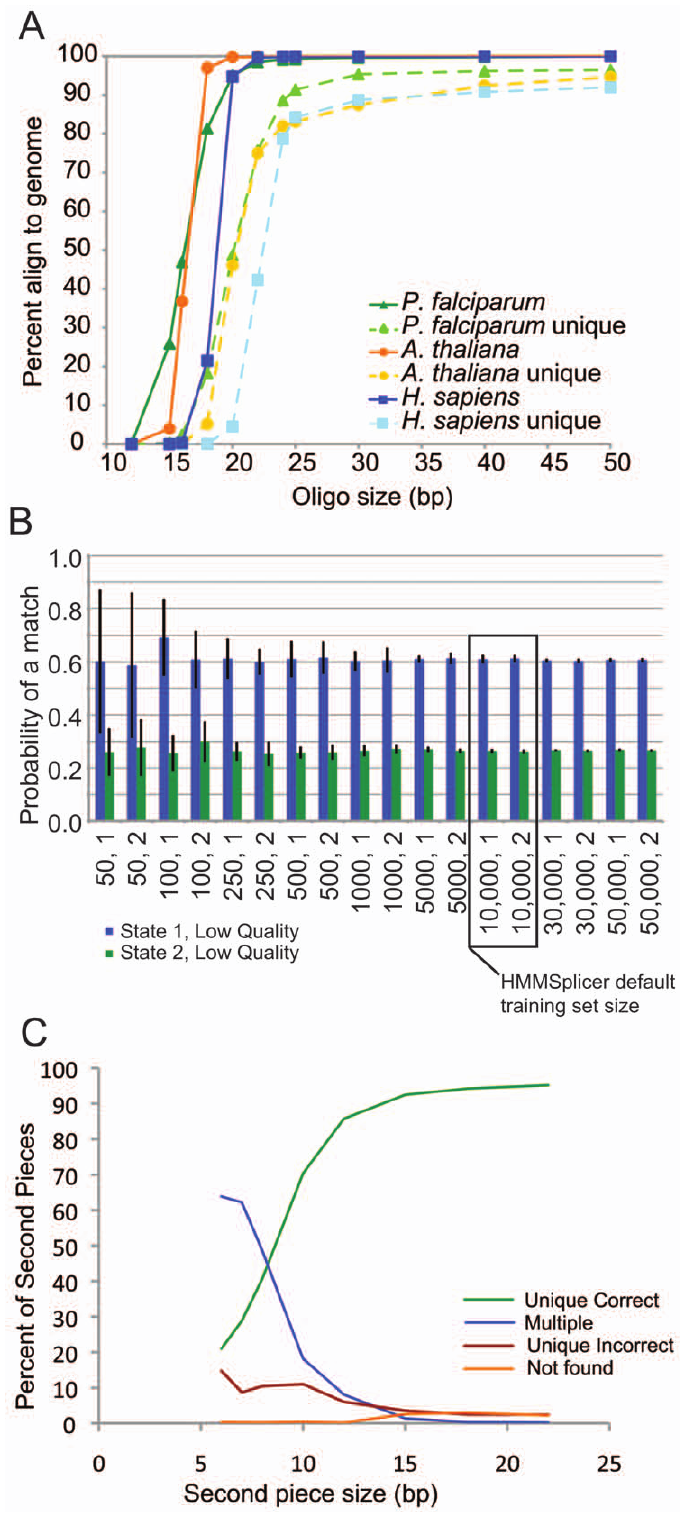
Figure 2. Algorithm parameters. a ) Percent of oligos able to map within a genome as a function of oligo size. The solid lines show the percentages if oligos are able to map up to 50 times within the genome (the value used in HMMSplicer seeding). The dashed lines show the percentages if a unique match is required. b ) HMM training. The values for the two most variable parameters of the HMM are shown here, with the x- axis representing different training set sizes and initial HMM parameters. The error bars show the standard deviation of ten repetitions of training. HMMSplicer uses a training subset size of 10,000. c ) Effect of size, in bases, for the second piece of the read. The percent of second pieces uniquely mapping within 80 kbp of the first piece increases as the size of the second piece increases, while the percent of second pieces mapping to multiple locations decreases.